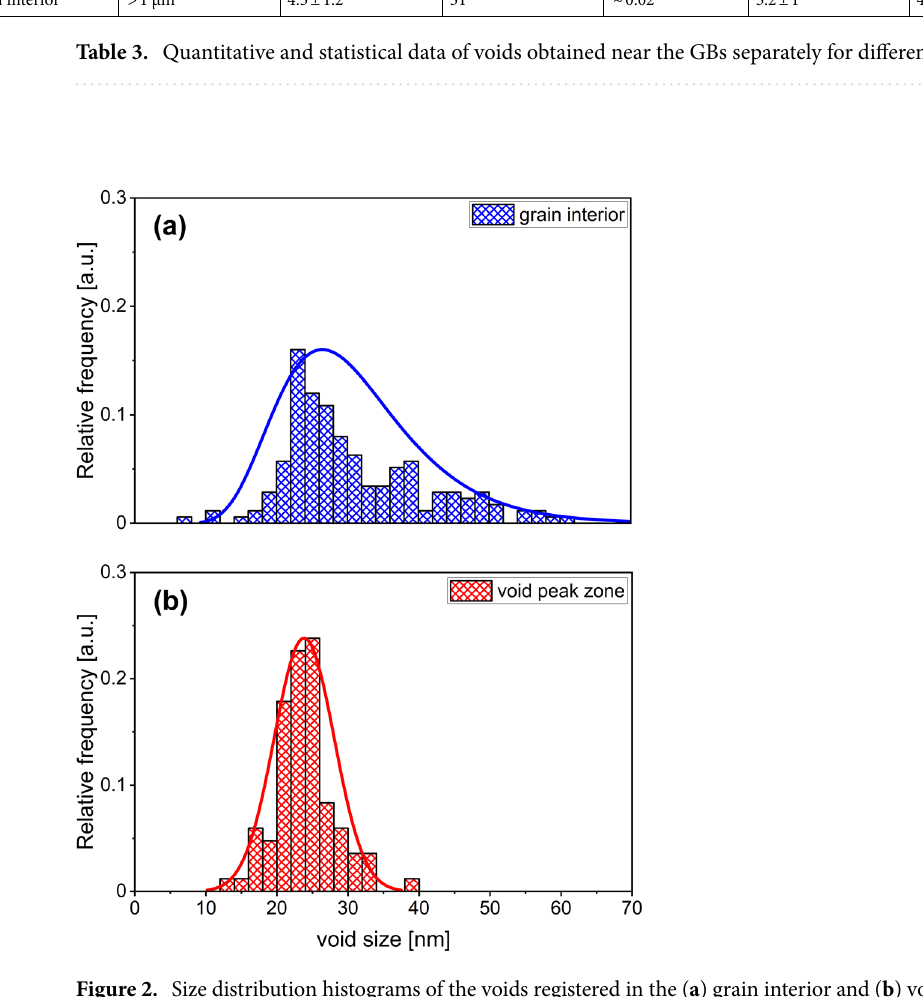
Figure 2. Size distribution histograms of the voids registered in the ( a ) grain interior and ( b ) void peak